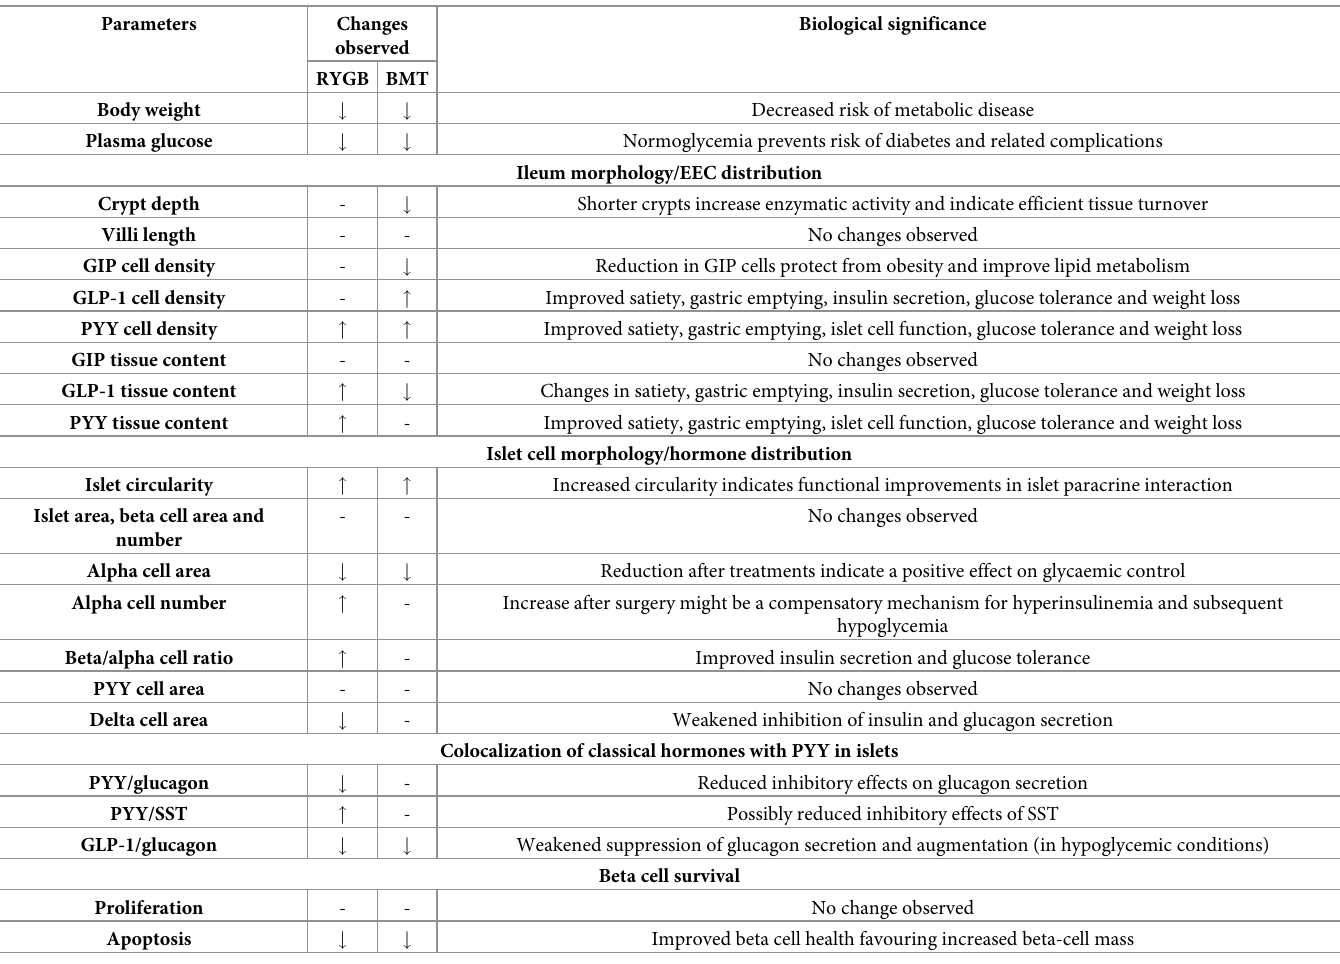
Table 2. Summary of results and their possible biological significance after RYGB surgery.